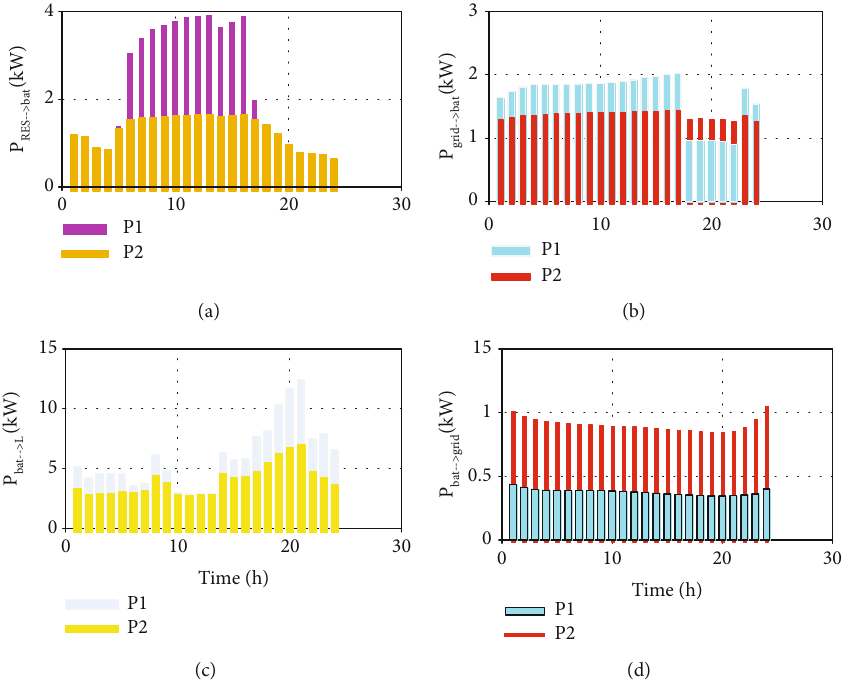
Figure 11: (a) Produced power from RES to charge the battery; (b) imported power from the utility grid to the battery; (c, d) discharged power from battery system to the load and grid, respectively.